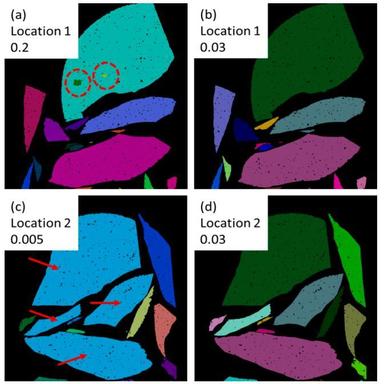
(a) shows a case of insufficient-merging with a threshold value of 0.2. Red circles indicate small parts of a particle failed to be merged with the main body. (b) shows the same location as (a), the issue of insufficient-merging is solved with a threshold value of 0.03. (c) shows a case of over-merging with a threshold value of 0.005. The four particles indicated by red arrows are incorrectly merged together. (d) shows the same location as (c), the issue of over-merging is solved with a threshold value of 0